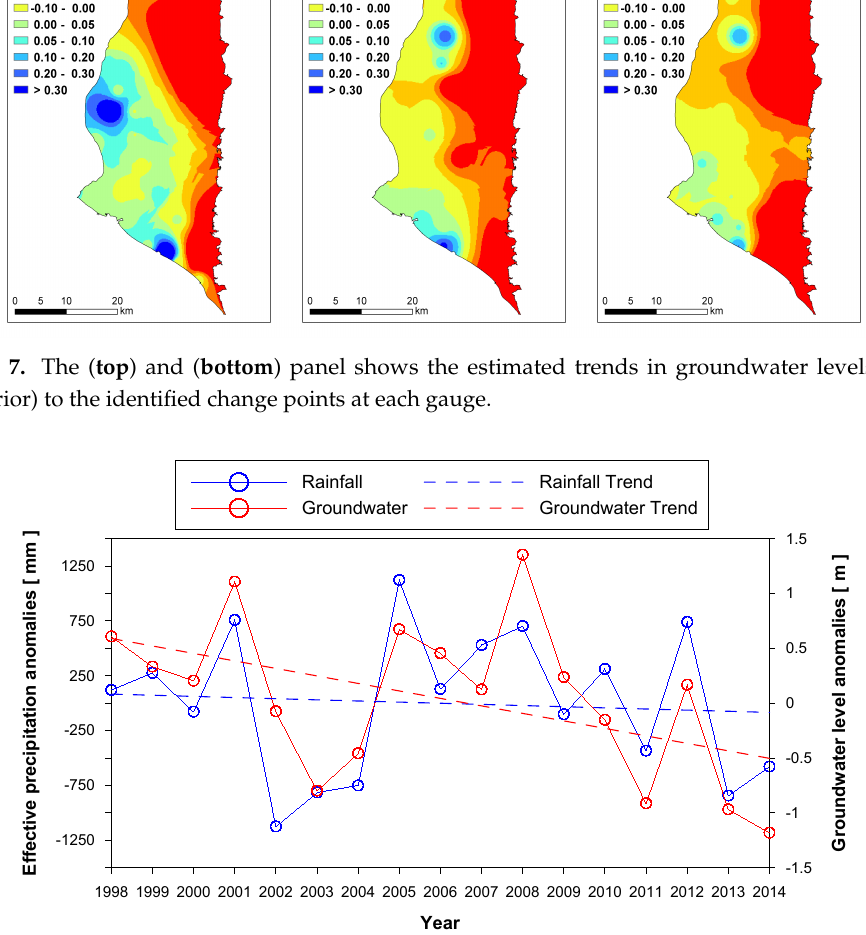
Figure 8. Annual series of average effective precipitation and groundwater level anomalies in Aquifer 3-1 and corresponding linear